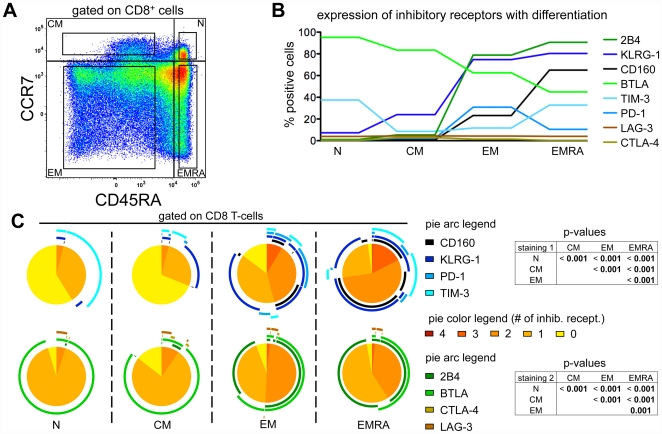
Expression profiles of inhibitory receptors with differentiation.(A) CD8 T-cell subsets were defined depending on expression of CCR7 and CD45RA, namely naive (N), central memory (CM), effector memory (EM) and effector memory RA+ (EMRA) cells. Gates used for inhibitory receptor analysis are shown in the four quadrants. (B) Mean values of inhibitory receptor expression in relation to the differentiation status. Individual values are shown in Figure S1B. n = 31 for “staining 1” (KLRG-1, TIM-3, PD-1 and CD160); n = 21 for “staining 2” (LAG-3, BTLA, 2B4 and CTLA-4); four samples of staining 1 were from healthy donors, the remaining from melanoma patients. (C) Co-expression of KLRG-1, TIM-3, PD-1 and CD160 (staining 1) and of LAG-3, BTLA, 2B4 and CTLA-4 (staining 2). Colors of the pie arcs depict the expression of individual inhibitory receptors, while the color in the pie depicts the number of co-expressed inhibitory receptors. p-values of the permutation test are shown in tables next to the corresponding pie charts. Co-expression was analyzed with SPICE 5.2.